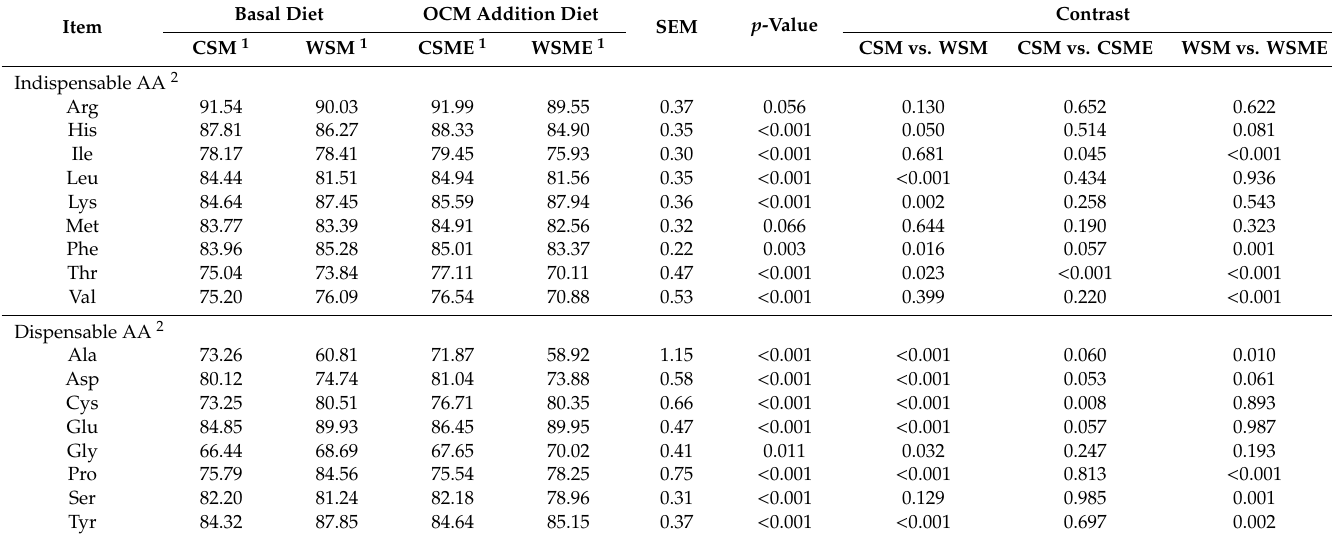
Table 7. E ff ects of the optimal carbohydrase mixtures on apparent ileal digestibility of amino acids in growing pigs fed two types of diets,